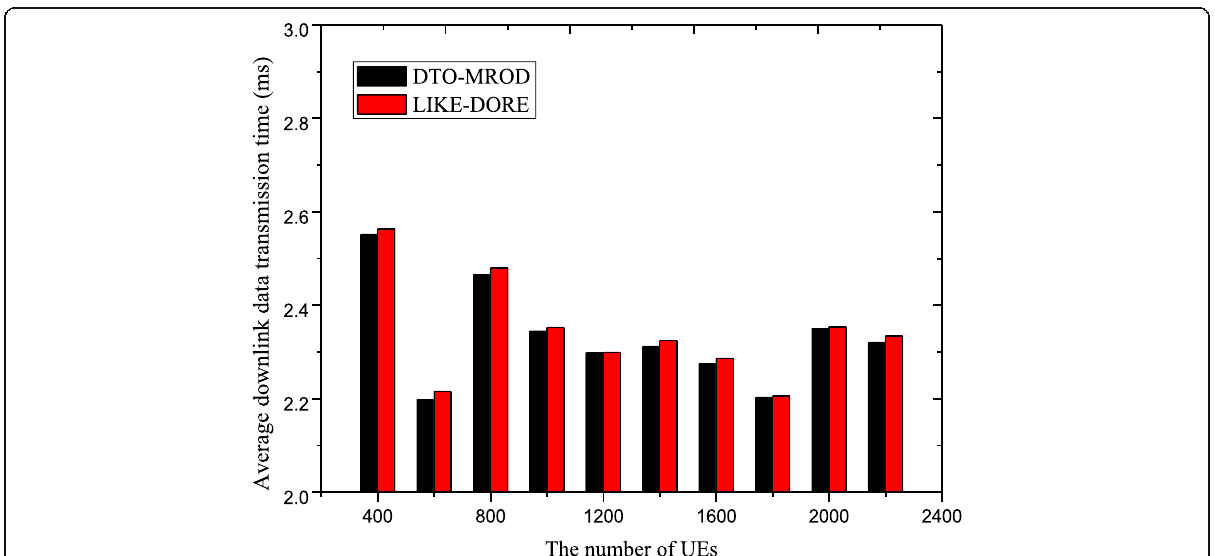
Fig. 8 Average downlink data transmission time for the two schemes under the different numbers of UEs